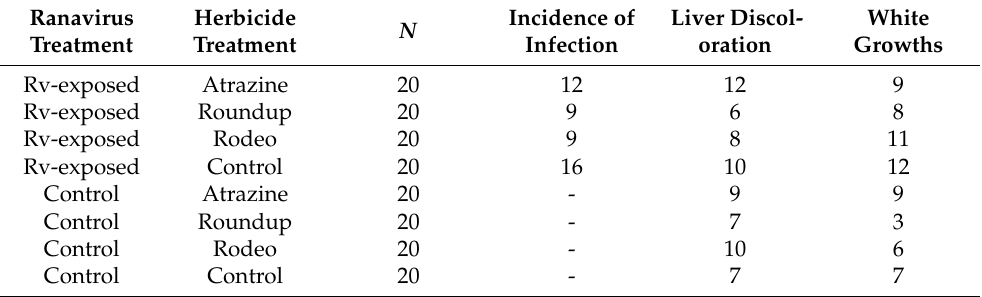
Table 1. Incidence of response variables at time of death among hatchling turtles ( Trachemys scripta elegans ) exposed to herbicide and ranavirus treatments. Rv-exposed turtles were injected with 100 uL of ranavirus-infected cell lysate (FV3; 6.3 × 10 4 TCID 50 ) into the pectoral muscles after 1 week of the experiment; controls were injected similarly with cell culture medium. Turtles were exposed to herbicides via water bath during the first 3 weeks of the experiment. The criterion for ranavirus infection (incidence in table) was Ct values <30 for duplicate quantitative PCR wells using intestine, kidney, and liver tissue. Liver discoloration and external appearance of white growths were observed upon necropsy. Necropsies were performed upon death prior to the end of the experiment or upon euthanasia at the conclusion of the 5 week experiment.